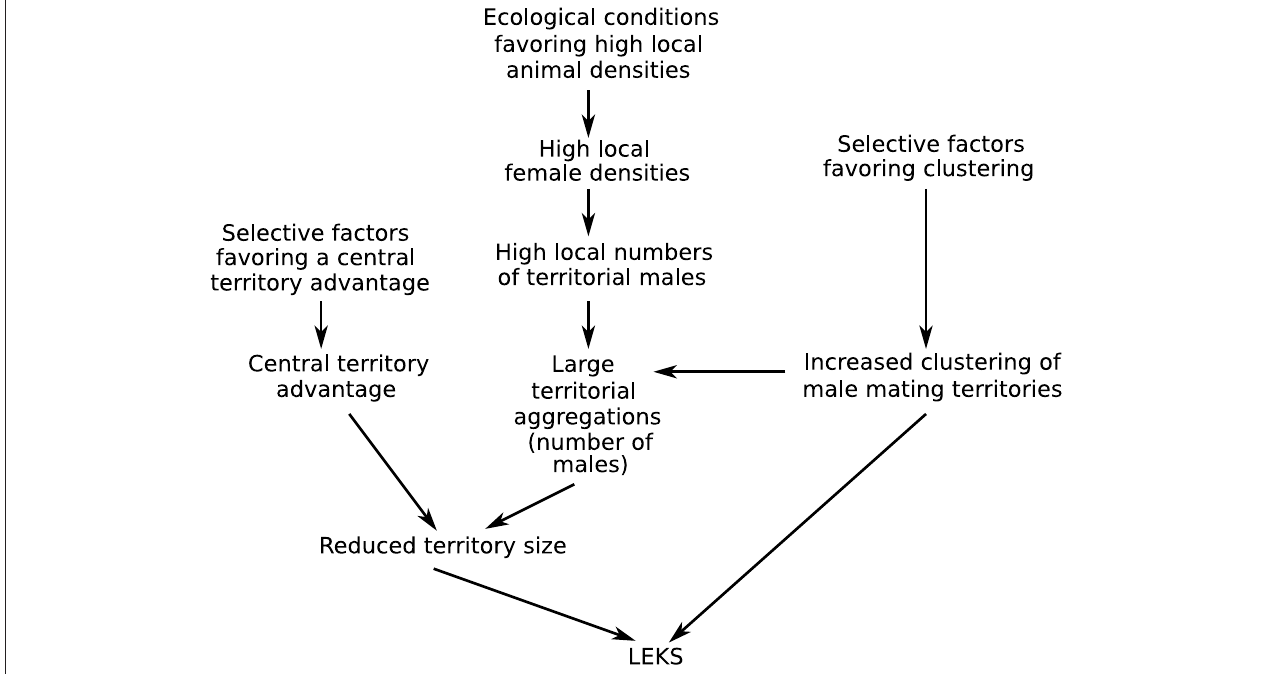
FIGURE 7 | A hypothesis for the evolution of leks that proposes that leks are the outcome of selection acting on two male traits: clustering of territories and the size of mating territory. Leks form when conditions favoring both male clustering and reduced territory size are met. This study, focusing on reduced territory size, proposes that both evolutionary and ecological factors interact to produce the tiny territories characteristic of classical leks. A central territory advantage (e.g., provided by a female bias for central territories) in large territorial aggregations likely results in reduced territory sizes. Large territorial aggregations (many males in an aggregation) are likely to be an outcome of the male decision to cluster interacting with ecological conditions that favor high local numbers of territorial